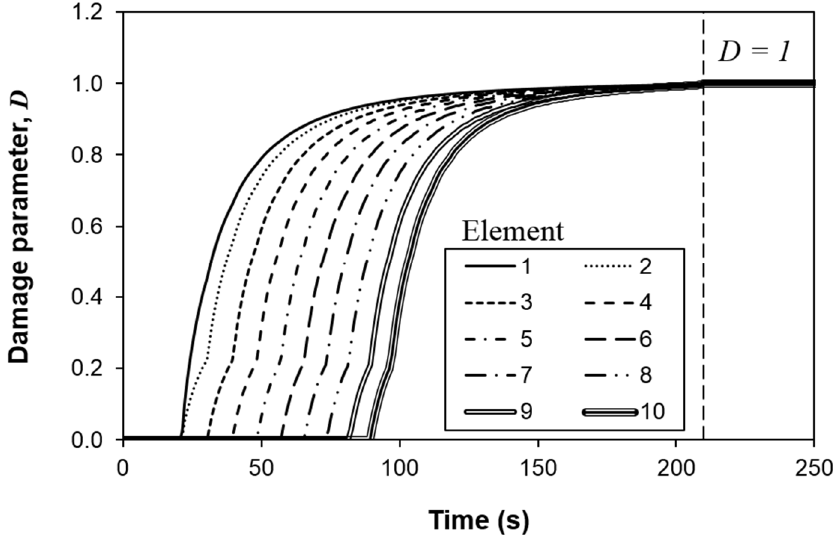
Figure 13. Variation of the cohesive zone length with respect to the displacement rate.